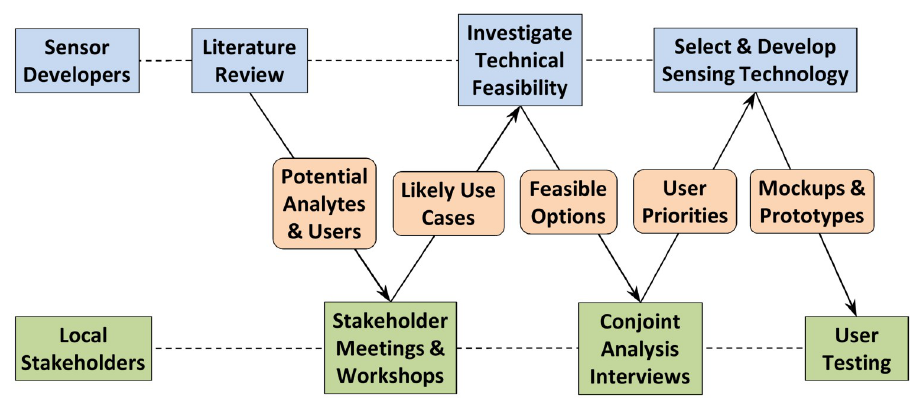
Fig 1. Proposed sensor development workflow incorporating fieldwork-based determination of design